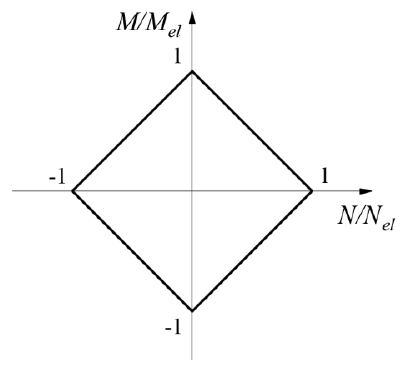
Figure 5. Dimensionless elastic domain.